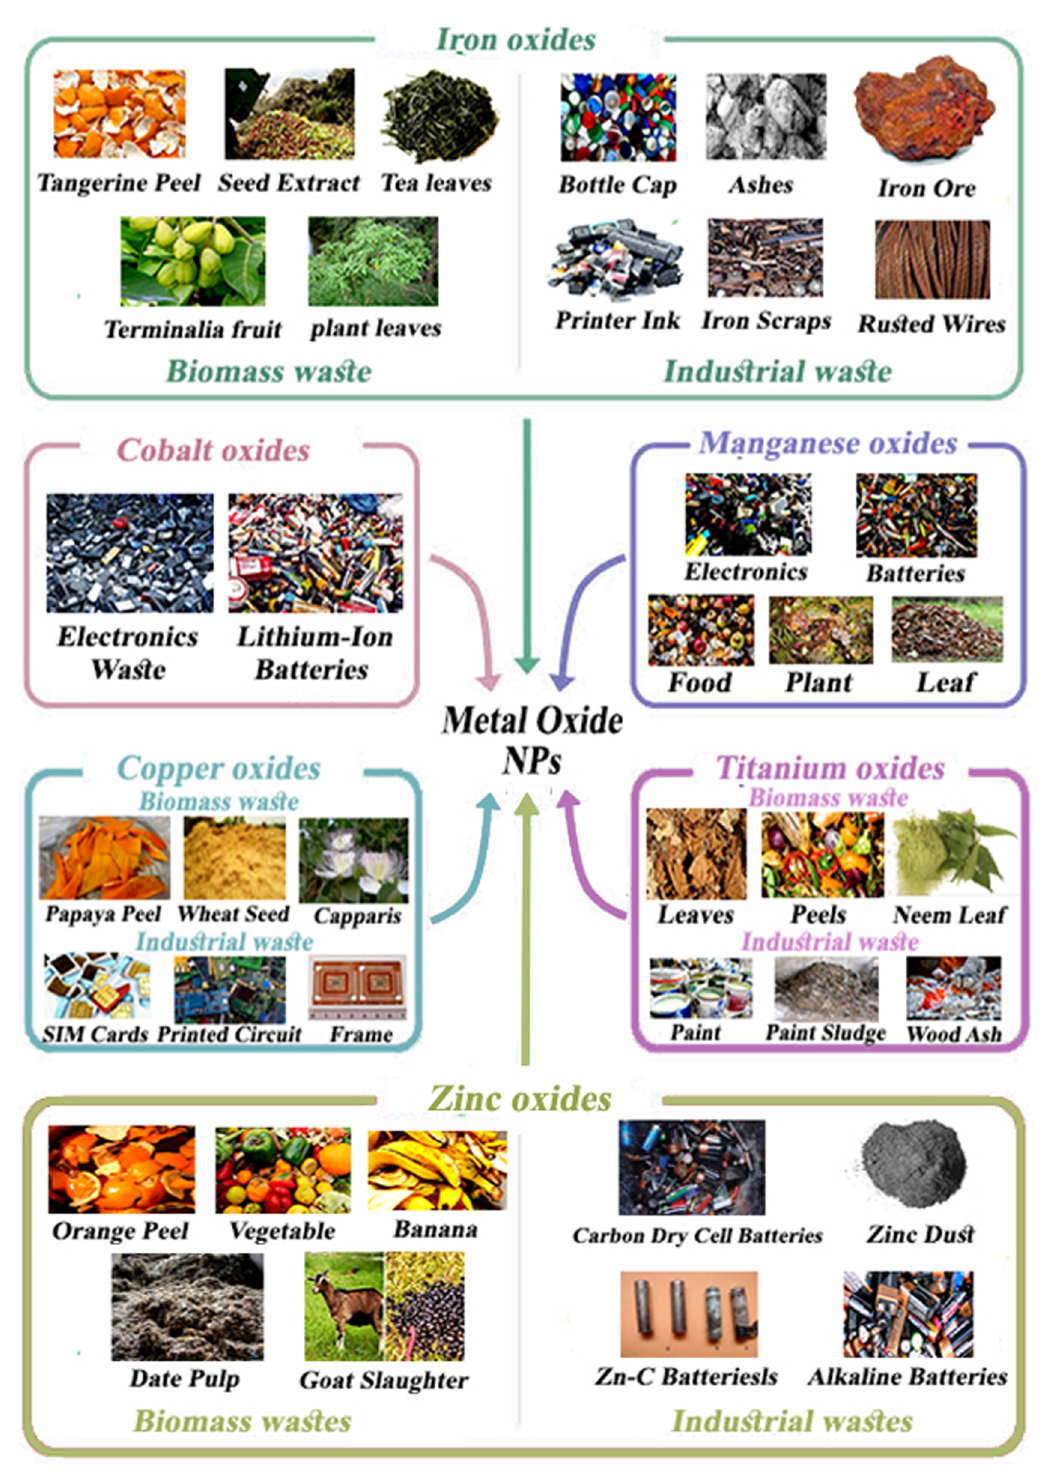
Figure 16: Wastes used as precursors for synthesizing di ff erent types of metal oxide